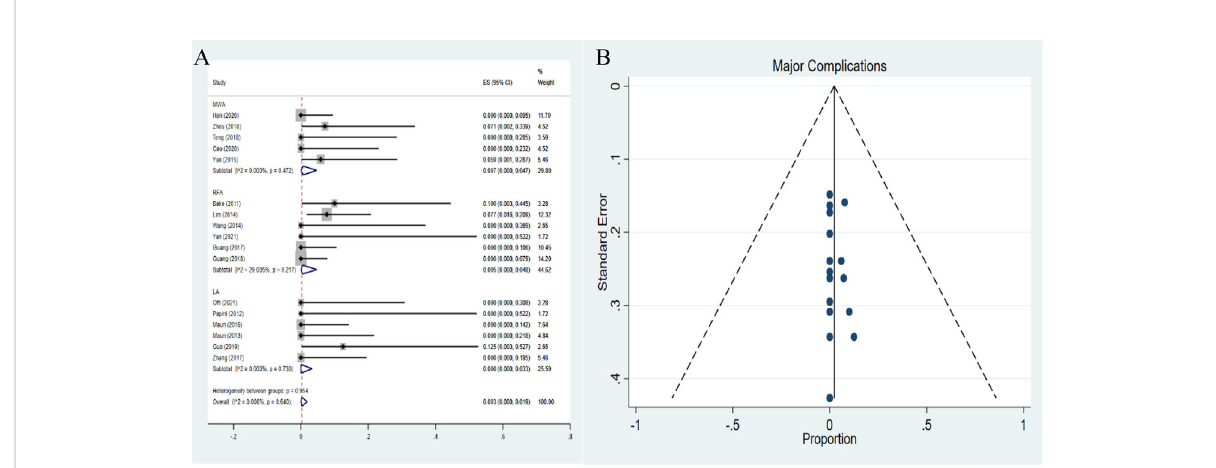
FIGURE 8 Forest plots (A) and funnel plots (B) of pooled major complications.